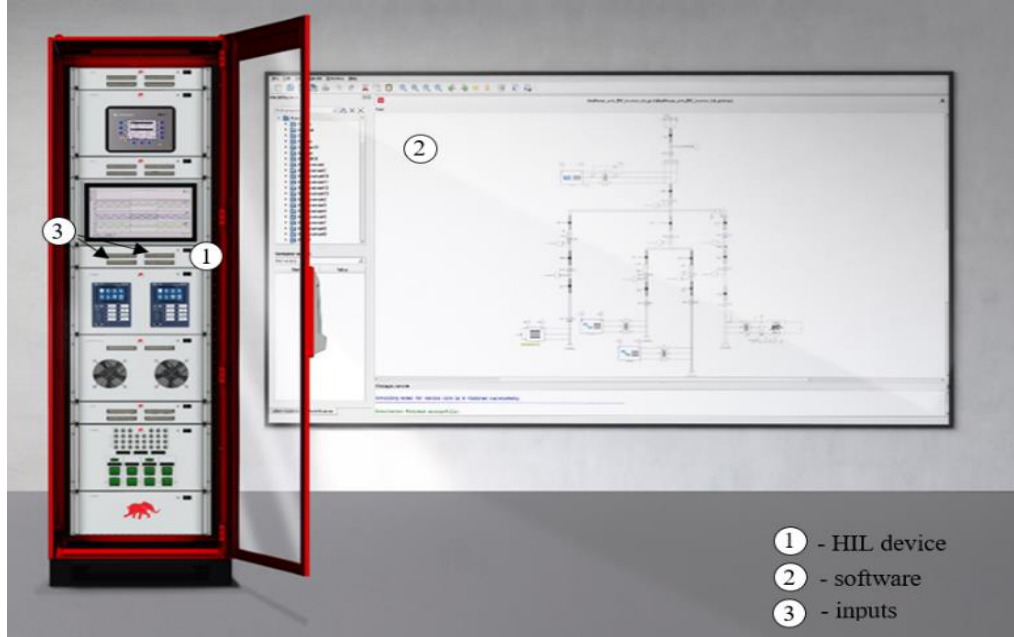
Figure 6. The Typhoon HIL setup environment.